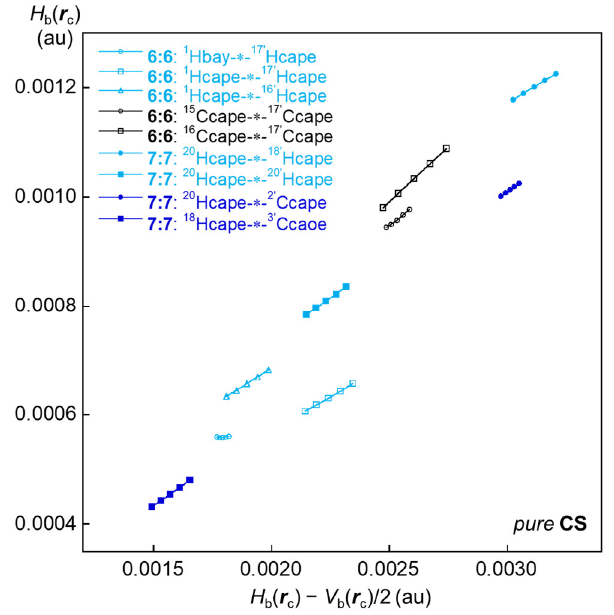
Figure 6. Plots of H b ( r c ) versus H b ( r c ) – V b ( r c )/2 for H- ∗ -H, C- ∗ -H, and C- ∗ -C at 6 : 6 ( C i ) and 7 : 7 ( C i ), calculated with M06-2X/6-311+G(3d,p). Table 2. QTAIM Functions and QTAIM-DFA Parameters Evaluated for the Fused Benzene-Type Helicenes of Concave-Type Dimers ( 6 : 6 and 7 : 7 ), Employing the Perturbed Structures Generated with CIV 1–3 .